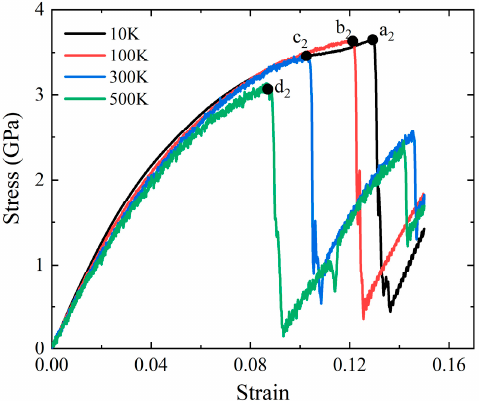
Figure 11. The stress-strain curves for single crystal Al-2%Mg alloys under uniaxial compression with different temperature. The four points, a 2 , b 2 , c 2 and d 2 , are the maximum stress at 10 K, 100 K, 300 K and 500 K, respectively.